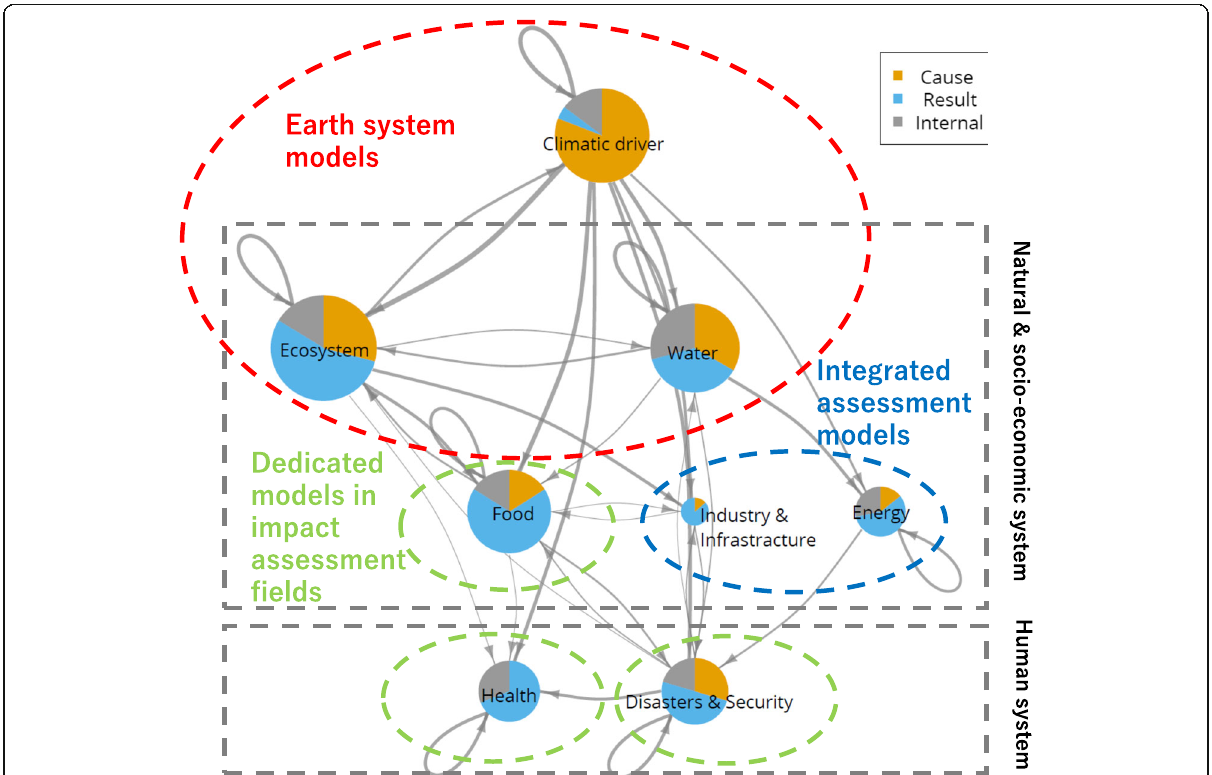
Fig. 4 Climate risks and their cause – effect relationships across different sectors, adapted from Yokohata et al. (2019b). Arrow thickness represents number of risk interconnections. Arrows connecting different sectors indicate intersectoral causal relationships, and those looping back to the same sector represent causal links within each sector. Node size reflects number of risks identified within the sector. Node color indicates the proportion of intersector causes (orange), effects (blue), and intrasector causes and effects (gray). Oval with a red dashed line shows the range covered by Earth system models, as reviewed here. Ovals with blue and green dashed lines show the ranges covered by integrated assessment models and dedicated models in the field of impact assessment, respectively, illustrating the complementarity of the diverse models used in environmental